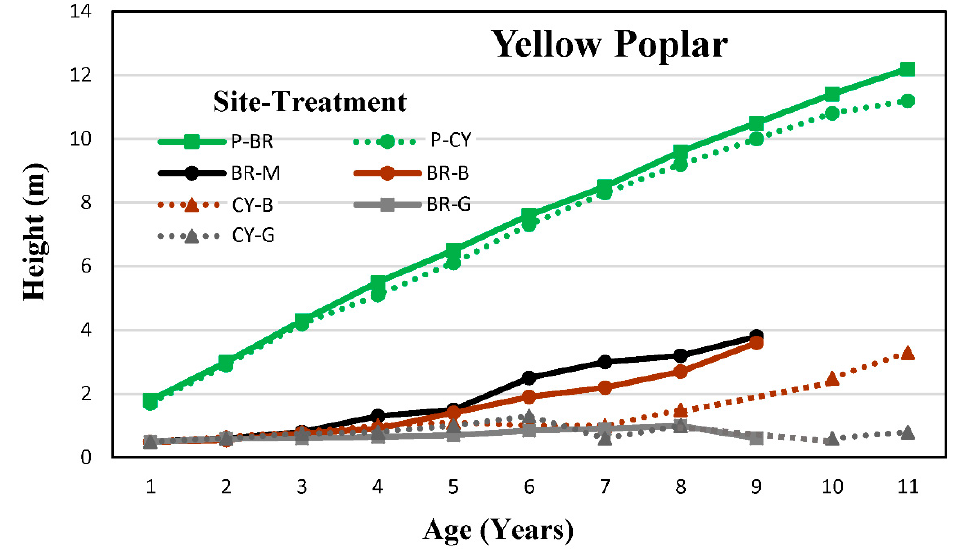
Figure 3. The height of tulip poplar growing in pre-mine native soils (P-BR and P-CY) and in brown (BR-B and CY-B) and gray mine soils (BR-G and CY-G) at two reclaimed mine sites. Annual growth rates for tulip poplar averaged about 1 m per year in pre-mine native soils (Table 7). For brown and mulched mine soils (BR-M, BR-B and CY-B), tulip poplar grew 0.24 to 0.44 m per year (65% to 75% lower). And the gray mine soils (BR-G and CY-G) showed no growth and had the lowest growth rates (0.02 m to 0.04 m per year) of any mine soil type. Table 7. Regression equation values for tulip poplar growing in pre-mine native soils (P-BR and P-CY) and in brown (BR-B and CY-B) and gray mine soils (BR-G and CY-G) at two reclaimed mine sites.